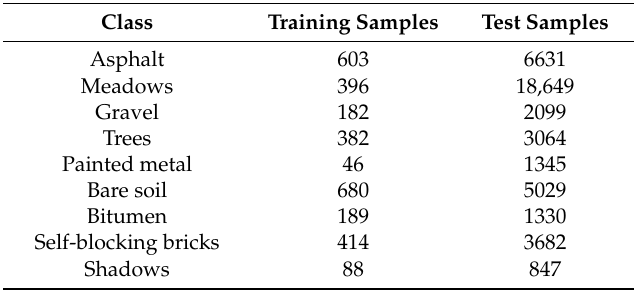
Table 1. Number of training samples and reference data for the Pavia University image.